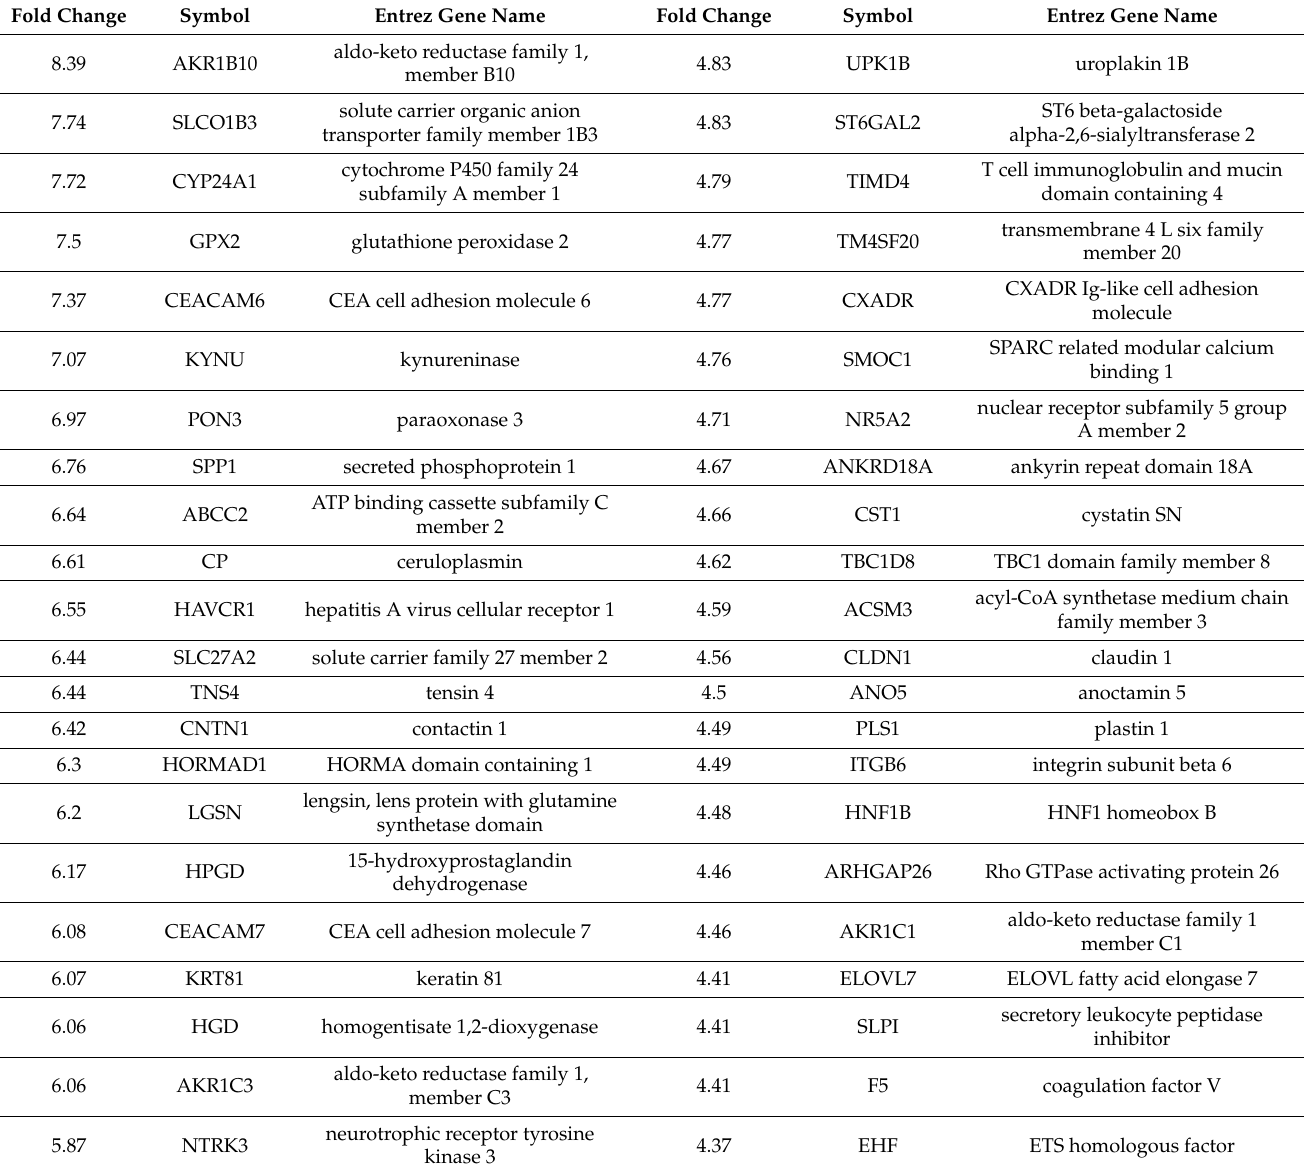
Table 1. The 100 most upregulated genes expressed by ELC after the MET from human lung fibroblasts are listed. Fold change for each gene is indicated; symbol and gene name are in progressive order of expression. Fold